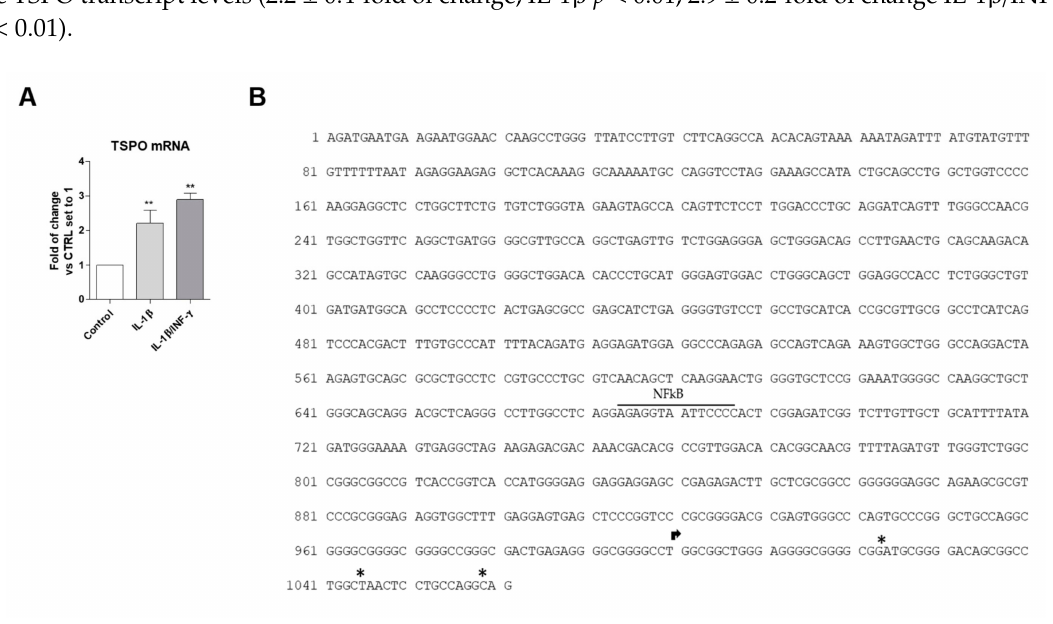
Figure 6. ( A ) TSPO gene expression in WT C20 cells. Cells were treated with IL-1 β (20 ng / mL) or IL1- β / INF- γ (100 ng / mL / 50 ng / mL) for 24 h in serum-free medium and TSPO mRNA transcript levels were assessed by qPCR, and expressed as fold of change versus the control, which was set to 1. Data are presented as the mean values ± SEM of two independent experiments. The significance of the di ff erences was determined by one-way ANOVA, which was followed by Bonferroni’s post-test: ** p ≤ 0.01 vs. control. ( B ) The figure shows the proximal promoter of the human TSPO , in which the nucleotide sequence for NF- κ B is labeled. The arrow indicates the TSS reported on the NCBI site. The asterisks indicate the TSS reported by Batarseh